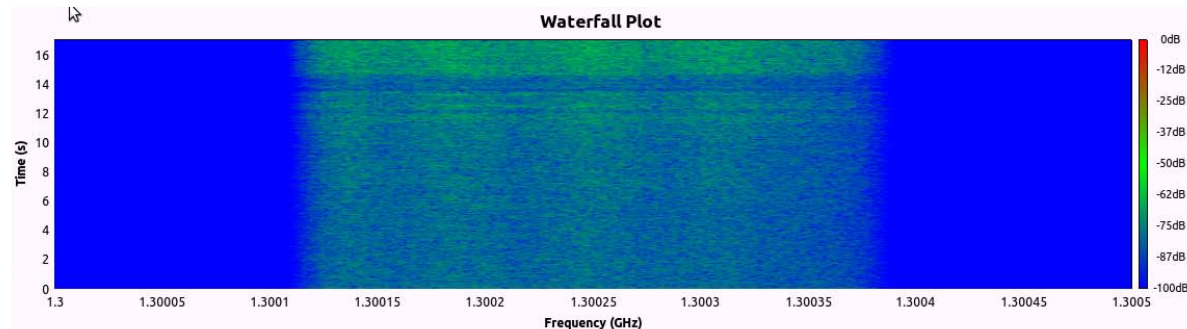
Figure 4. Primary user sends at multiple bands.